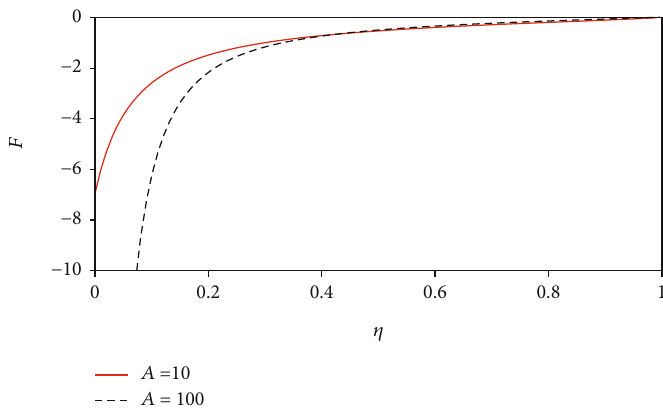
Figure 12: Plots of Equation (40) versus η for r = 0 : 5 and κ = 0 : 8 and for di ff erent values of linear gain coe ffi cient.